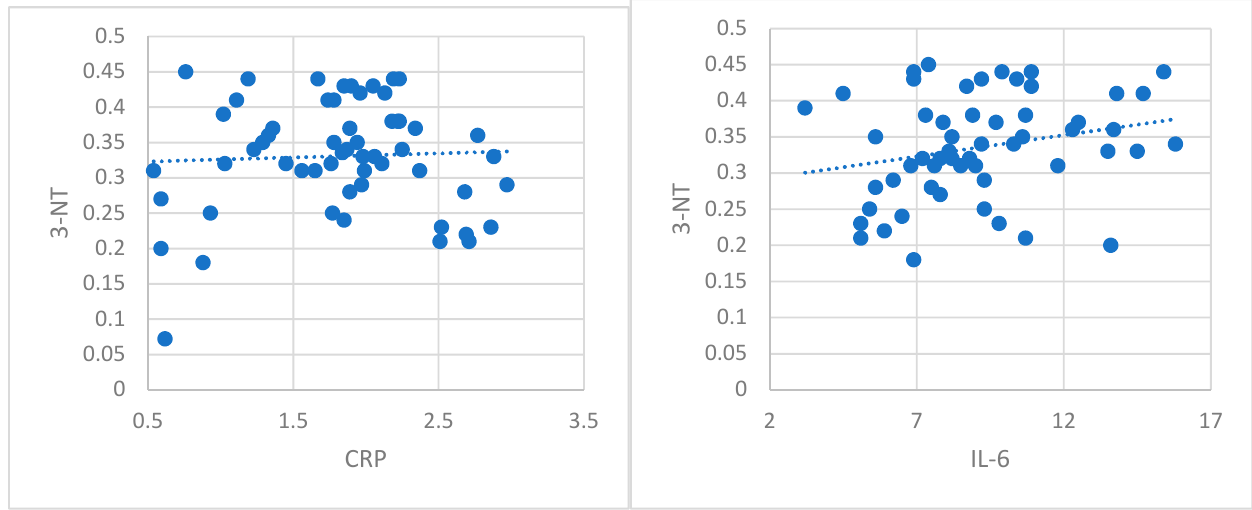
Figure A4. 3-NT and IL-6 and